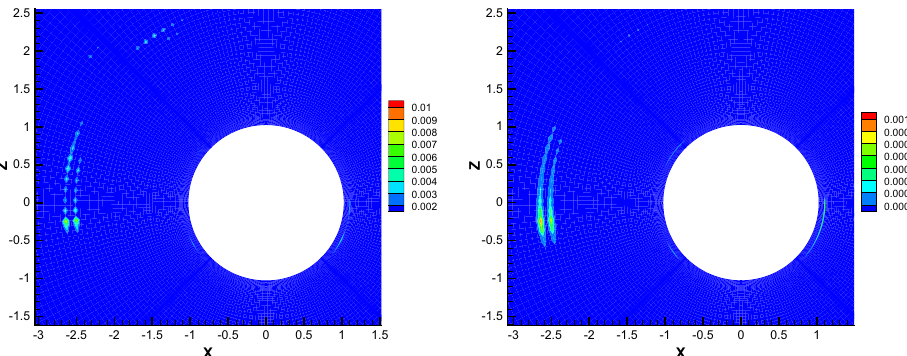
Fig. 3. The error introduced by the non-solenoidal magnetic fi eld on the Lorentz force (left) and magnetic fi eld (right). We de fi ned jðr(cid:2) B Þ B j as error introduced by the non-solenoidal magnetic jðr(cid:5) B Þ(cid:5) B j fi eld on the Lorentz force, and (cid:1) x jr(cid:2) B j as error introduced by j B j